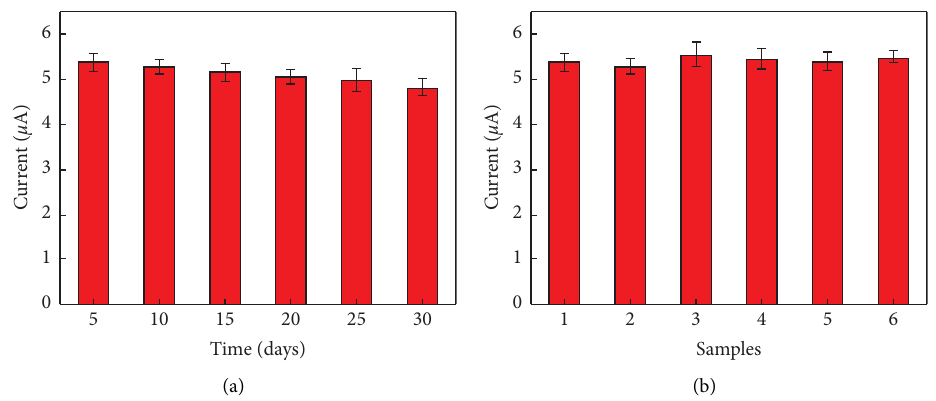
Figure 6: (a) Te stability and (b) reproducibility of the CEA immunosensor. Error bars � SD ( n � 5).